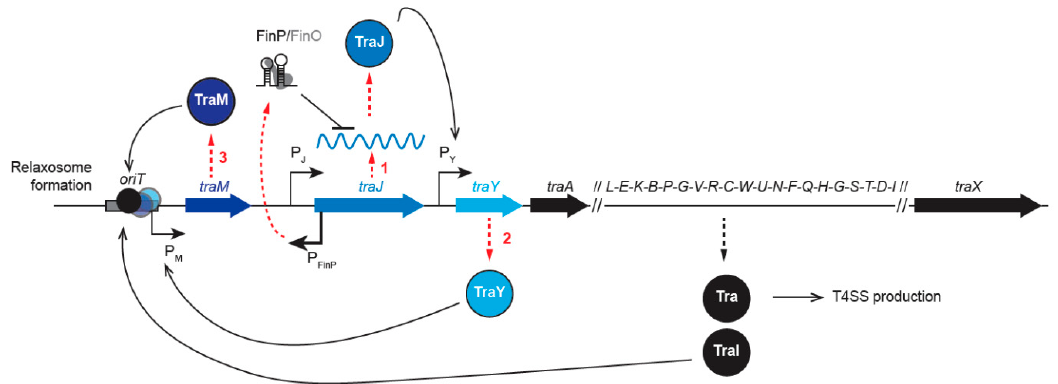
Figure 2. Activation cascade of tra gene expression. The P J promoter first drives traJ expression (1). Translated TraJ protein binds to the P Y promoter to notably produce TraY, which activates the P M promoter (2), other Tra proteins constituting the T4SS, and the relaxase TraI. Once produced (3), TraM autoregulates its own expression through the P M promoter and, in combination with TraY and TraI, forms the relaxosome bound to oriT . The activation of this regulatory cascade is modulated by the FinP/FinO complex, which represses the translation of TraJ at the post-transcriptional level. Dotted red arrows illustrate the transcription–translation process.